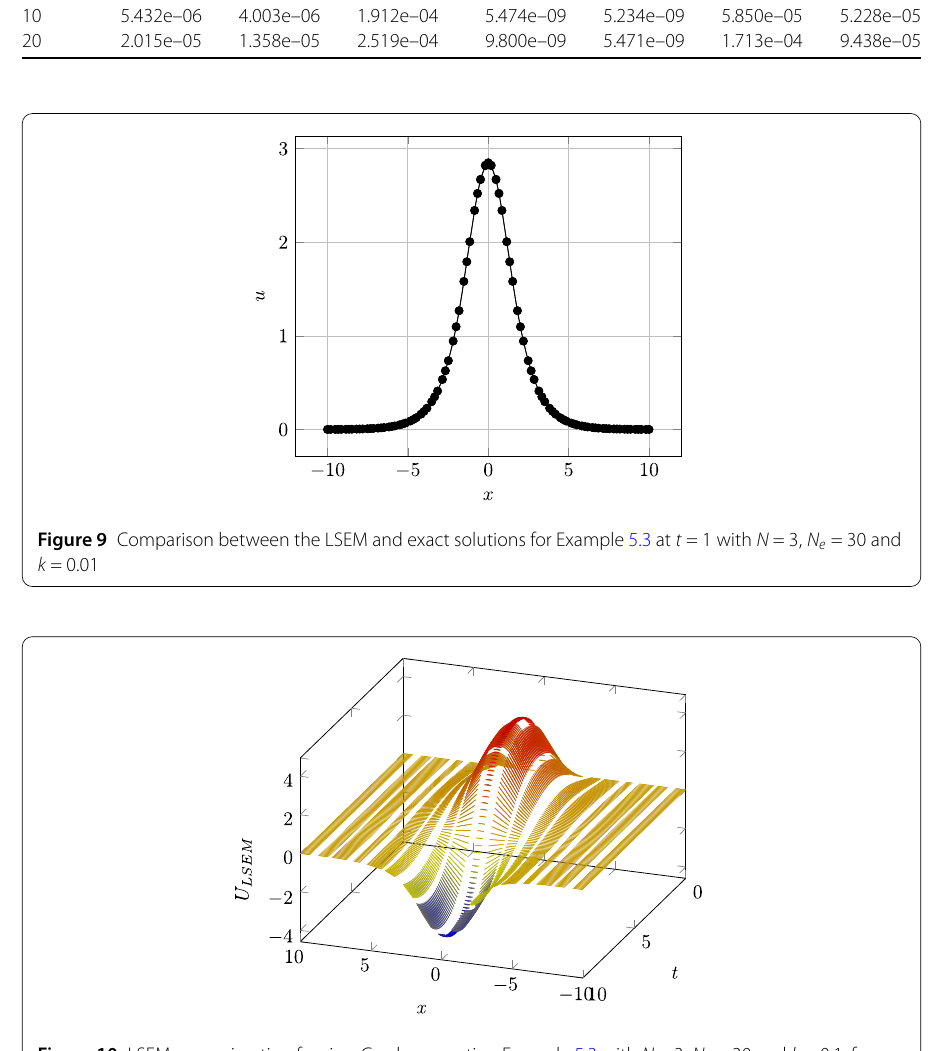
Figure 10 LSEM approximation for sine-Gordon equation Example 5.3 with N = 3, N e = 30 and k = 0.1, for t ≤